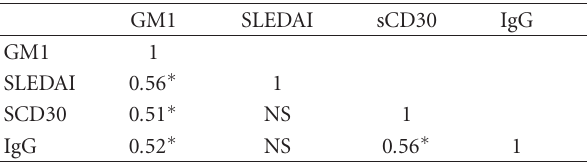
Table 1: Correlations among the levels of sCD30 IgG, GM1 expression, and SLEDAI scores ( ∗ P < .